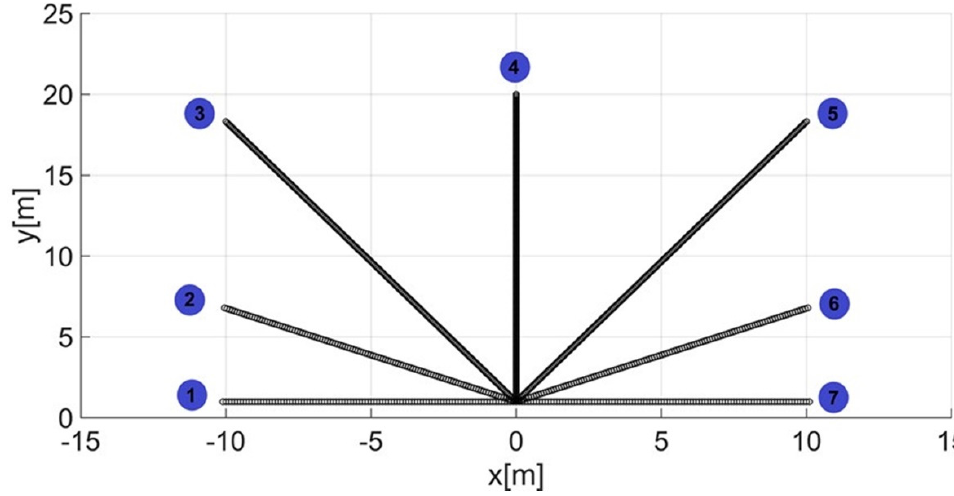
Figure 1. Guide paths 1 − 7 with the adopted xy coordinate system [6].